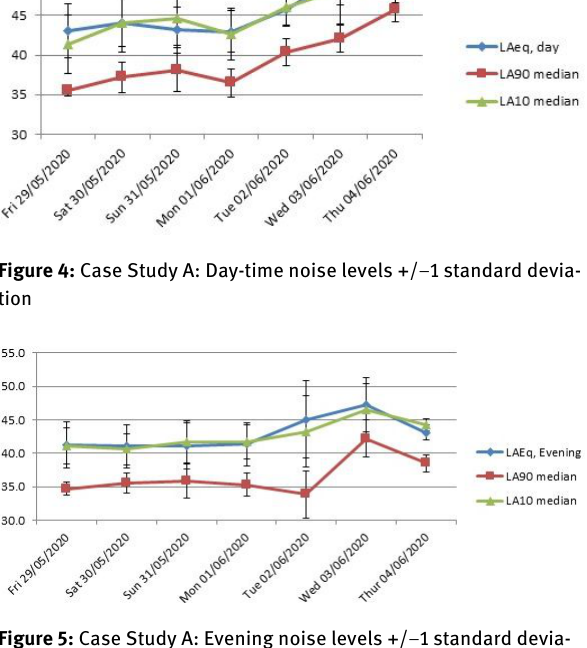
Figure 5: Case Study A: Evening noise levels +/ − 1 standard devia-